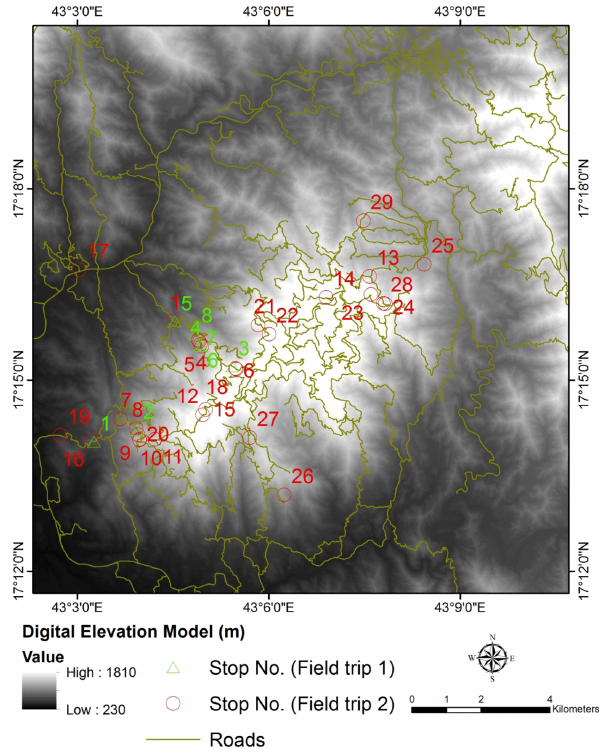
Figure 3. Location map showing the stops visited throughout field trips 1 and 2.